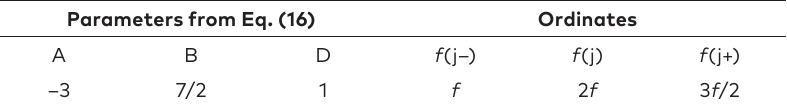
Table 1. Geometric characteristics of function f ( x ) Parameters from Eq.